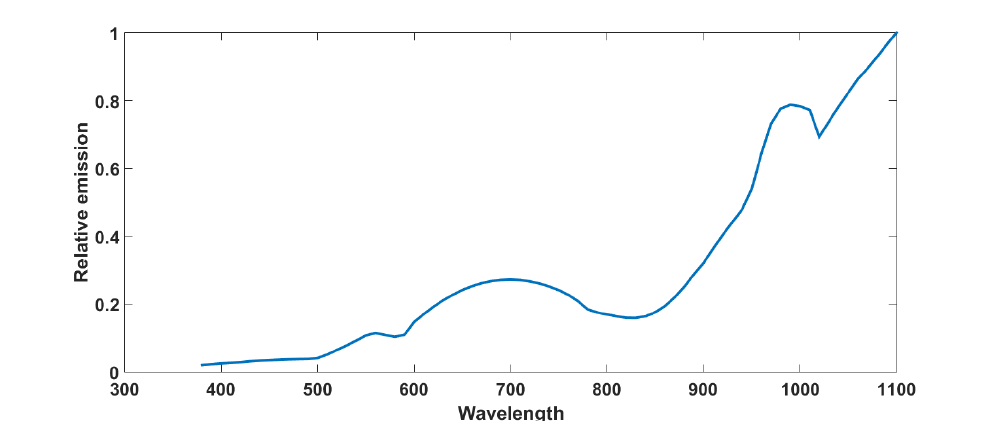
Figure A2. Relative energy emission by wavelength of the light source used in the measurements. The light source has been measured by using the OL DH-300EC silicon